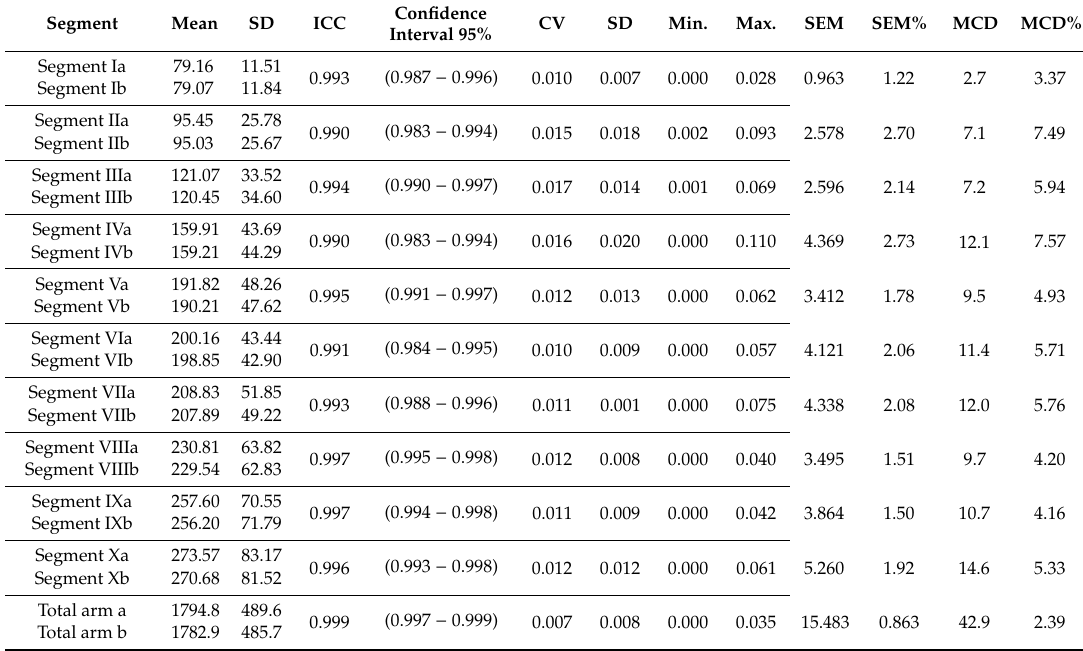
Table 3. Values and reliability of the volume estimation of the upper